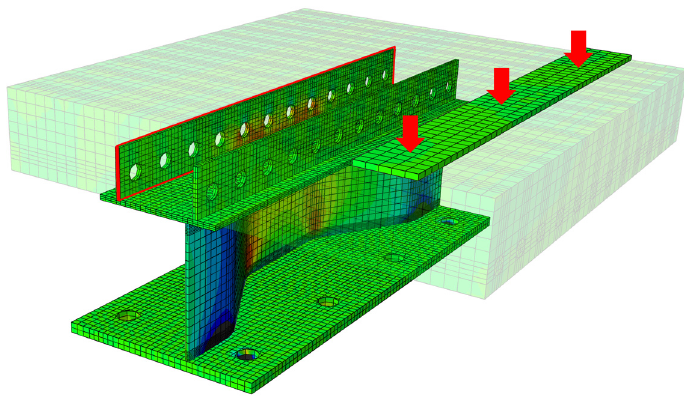
Figure 17. Stress status of the PBL under transverse bending moments.